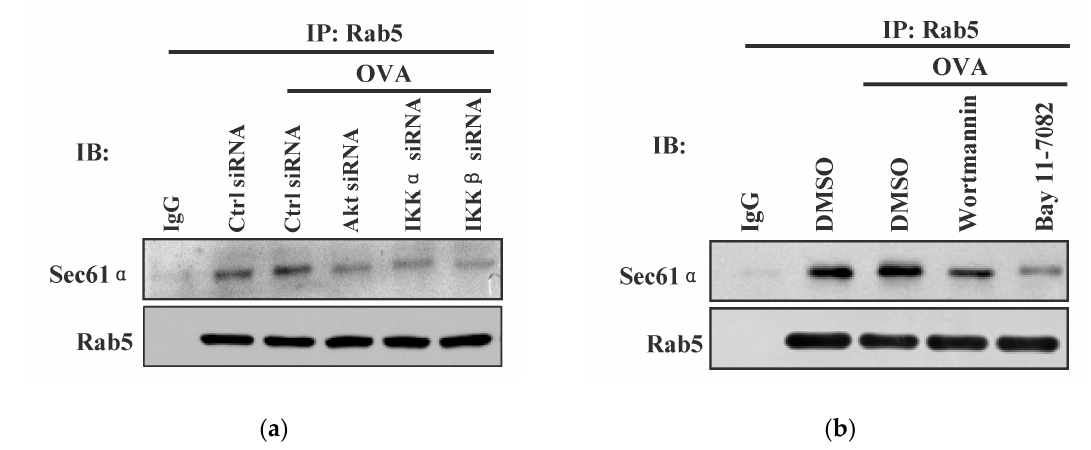
Figure 5. Akt + IKK α / β + Rab5 + signalosome facilitates endotoxin-containing pathogen-derived the Figure 5. Akt+ IKK α / β + Rab5+ signalosome facilitates endotoxin-containing pathogen-derived the relocation of Sec61 α . Murine scramble, Akt / IKK α / IKK β deficient ( a ), or Bay11-7082 / relocation of Sec61 α . Murine scramble, Akt/IKK α /IKK β deficient ( a ), or Bay11-7082/wortmannin (5